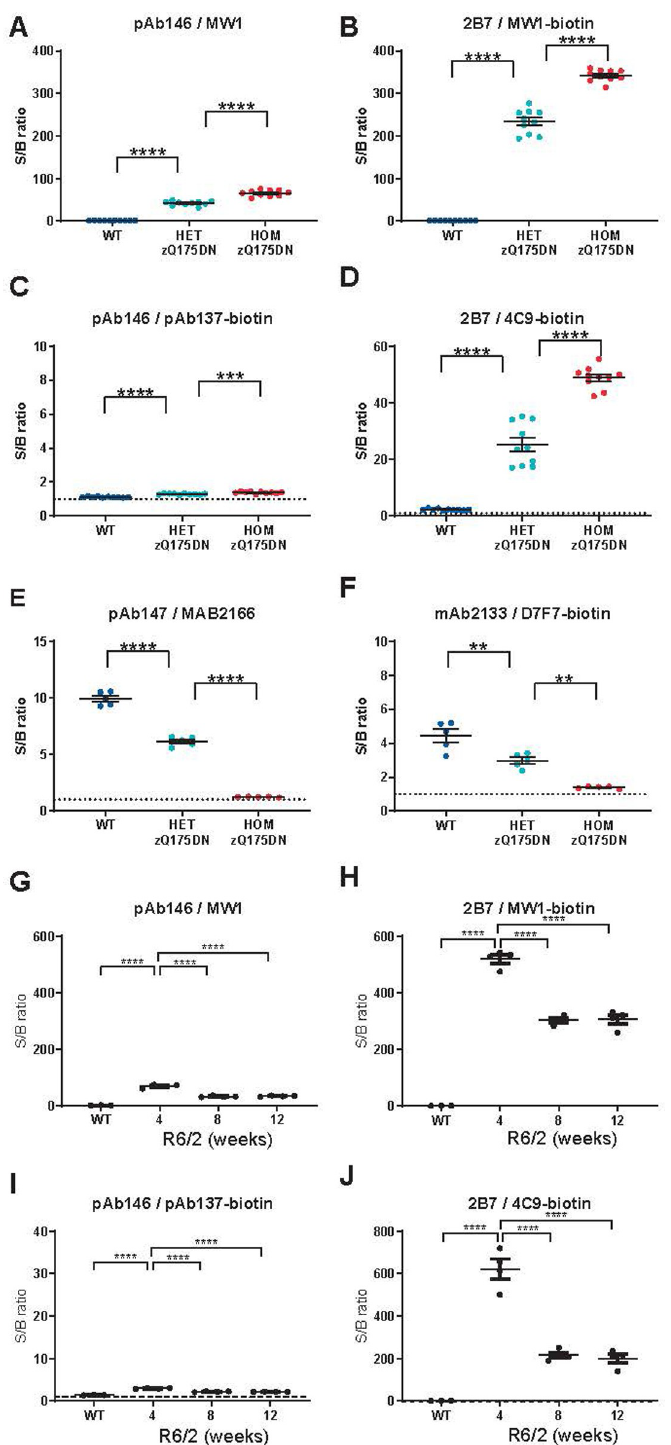
Fig 4. Comparison of HTT MSD assays employing only monoclonal antibodies (right-hand panels) with existing assays using polyclonal antibodies (left-had panels). Panels show gene dosage effect in wild type, heterozygous and homozygous zQ175DN knock-in mouse striatal lysates (A-D) and zQ175DN mouse brain hemisphere lysates (E, F), and age-related HTT levels in wild type and R6/2 mouse brain hemisphere lysates (G-J). Dissected snap-frozen tissues were lysed and analyzed with HTT MSD assays employing the indicated antibody combinations for capture/detection